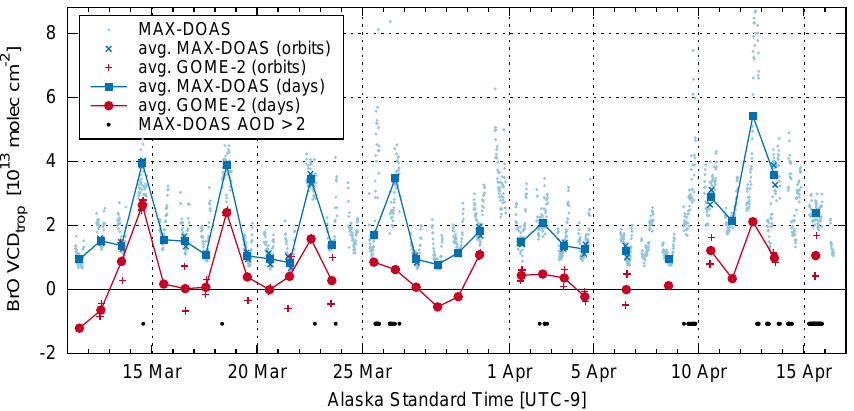
Fig. 16. Time series of retrieved BrO VCDs from ground-based MAX-DOAS measurements at Barrow, Alaska, 2009 compared to retrieved = 1), same data as in Fig. 18c. Black dots denote MAX-DOAS measurements, where the tropospheric BrO VCDs from GOME-2 (AMF min 500 surface aerosol optical density (AOD) exceeded 2. Error bars are omitted for the sake of clarity.